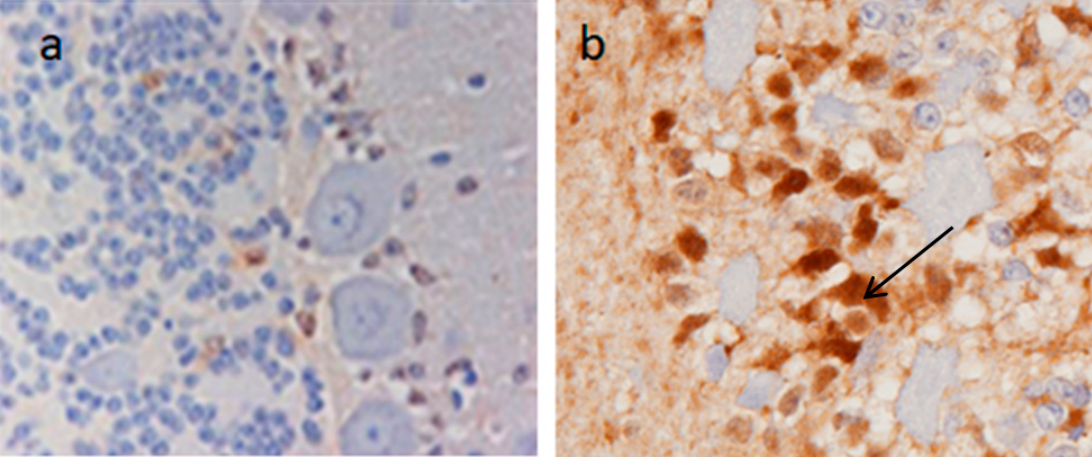
Figure 4. Comparison of MT expression in BBB of adult sheep cerebellum of both domesticated and feral North Ronaldsay sheep. ( a ) Control sheep cerebellum (Cu 15.4 µg/g) with weak MT immunostaining of astrocytes. ( b) North Ronaldsay sheep cerebellum (Cu 35.0 µg/g) showing strong MT (Cu-MT) staining of astrocytes (arrow). (Zn remained unchanged [18]). (Reproduced with permission from Haywood, J. Comp. Path.; published by Elsevier Ltd, 2013).